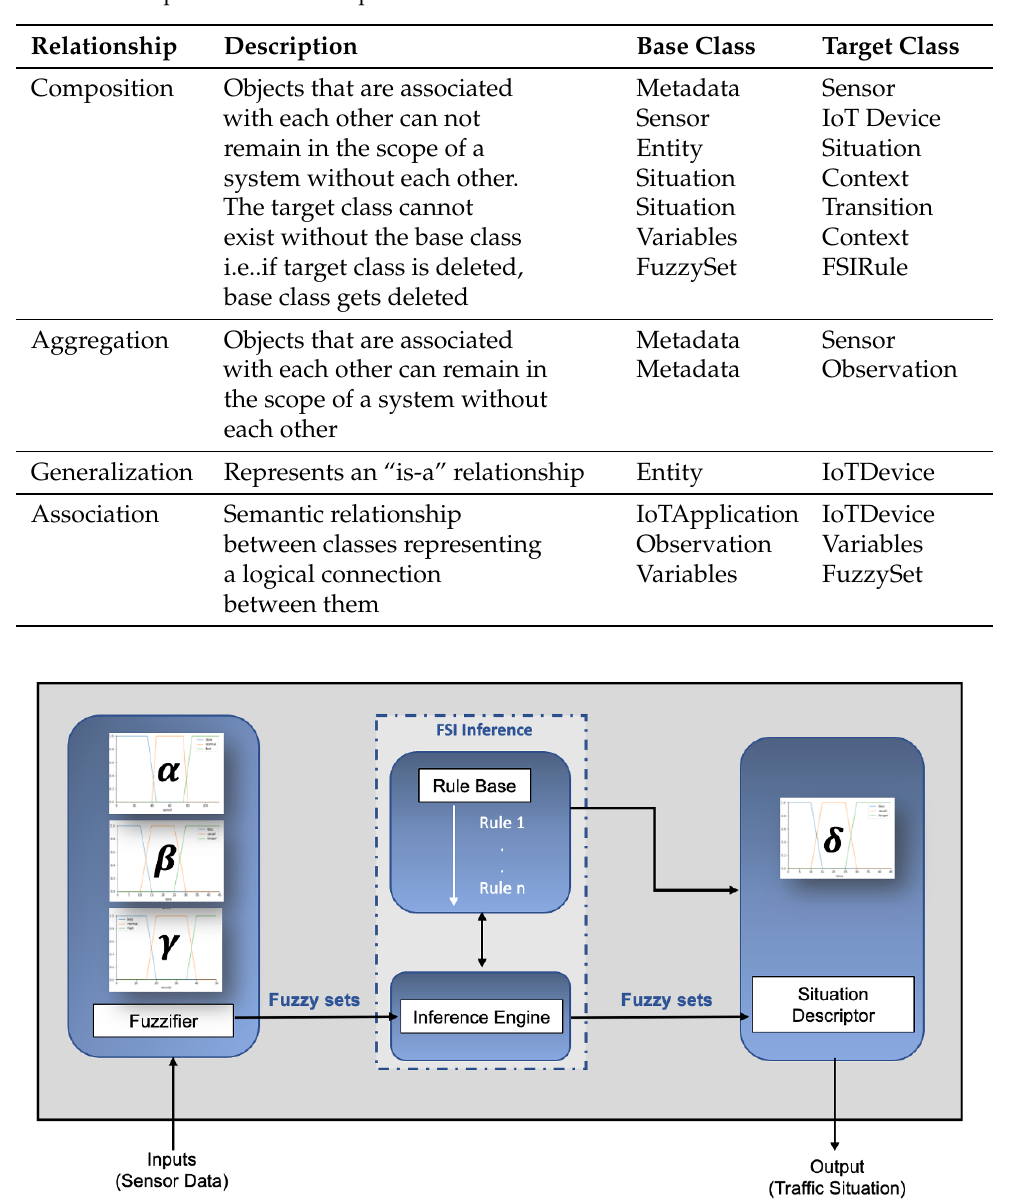
Table 2. Description of Relationships.